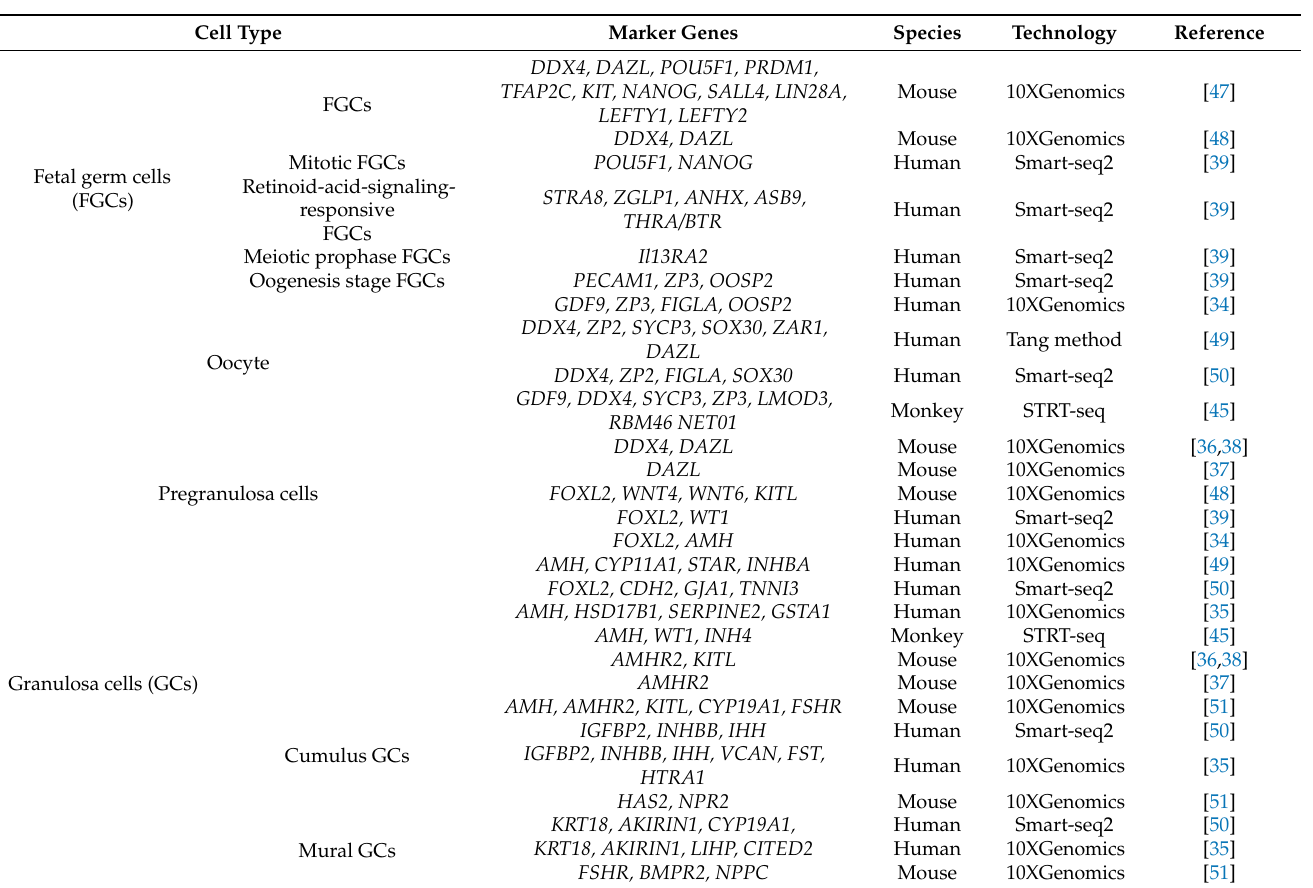
Table 1. Possible marker genes of ovarian cells in different species demonstrated by single-cell RNA